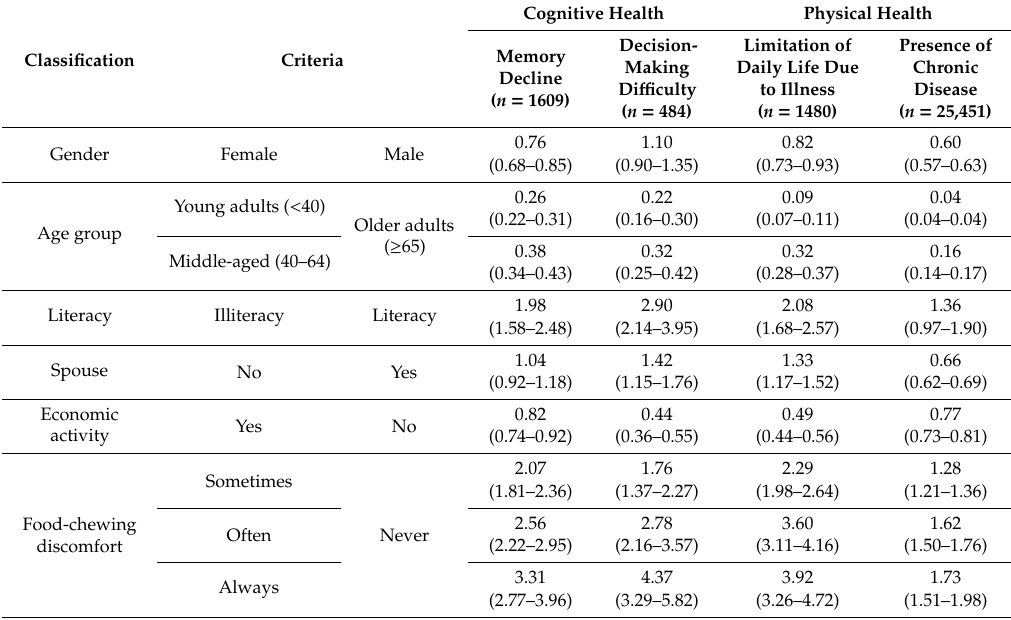
Table 6. Odds ratios of cognitive and physical health by food-chewing discomfort through multiple logistic